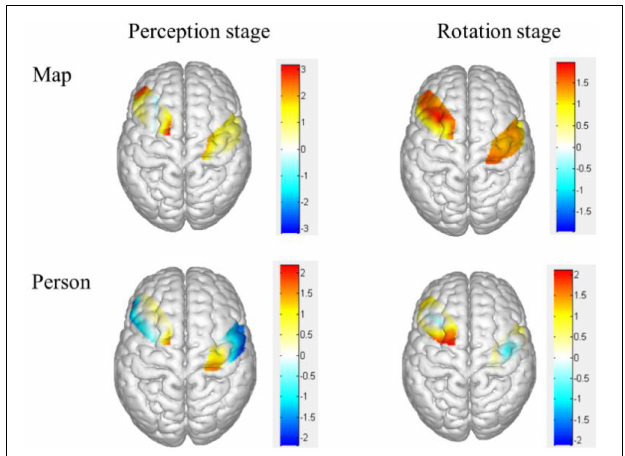
FIGURE 4 | Heat map of t -values for the comparison of different groups of brain activation in different stages. The upper was the object mirror images, and the bottom was the subject mirror images. The bigger the two groups, the thicker the